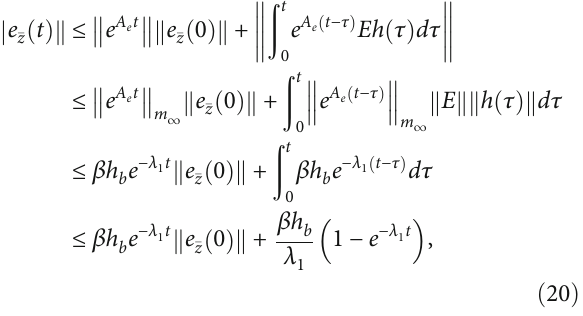
Figure 7: The evolution curves of the three controllers.